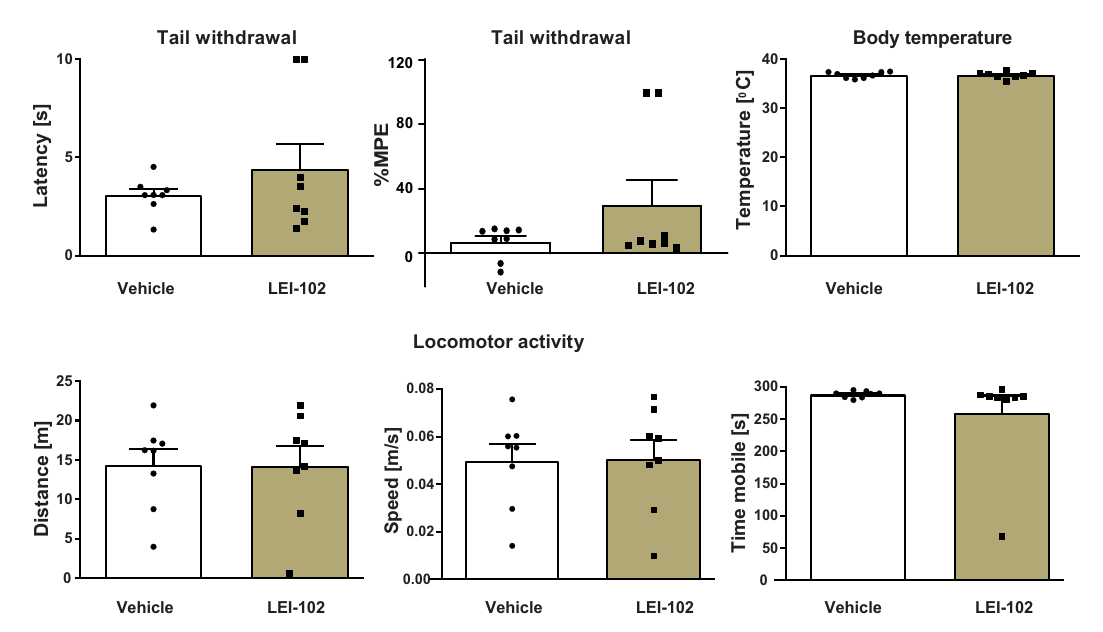
Fig.6|TheCB 2 RagonistLEI ‐ 102doesnotinducecannabimimeticCB 1 R-mediated effects (Tetrad assay) in vivo. LEI ‐ 102 (25mg/kg, p.o.) did not affect nociceptive behavior assessed in tail withdrawal test and body temperature, as compared with